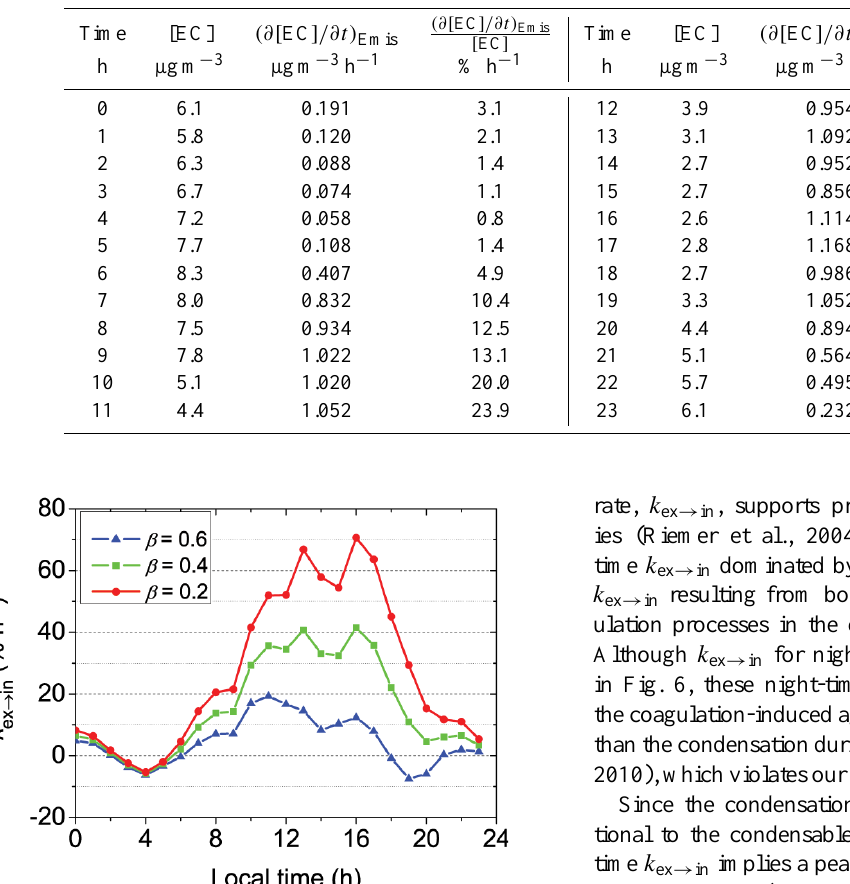
Table 3. Mean diurnal variation of [EC] (EC concentrations) and (∂ [ EC ] /∂t) Emis (emission rates).